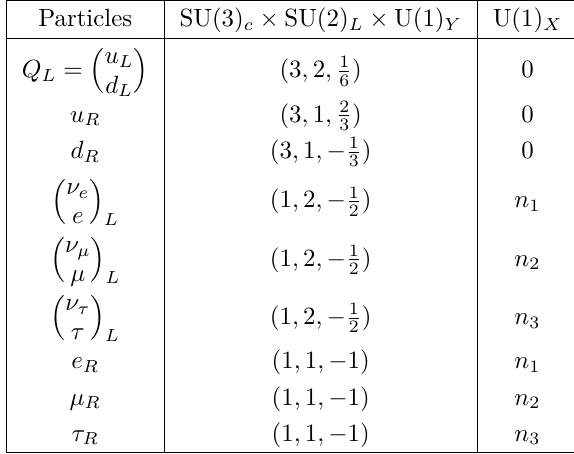
Table 1 . U(1) X charges of the SM